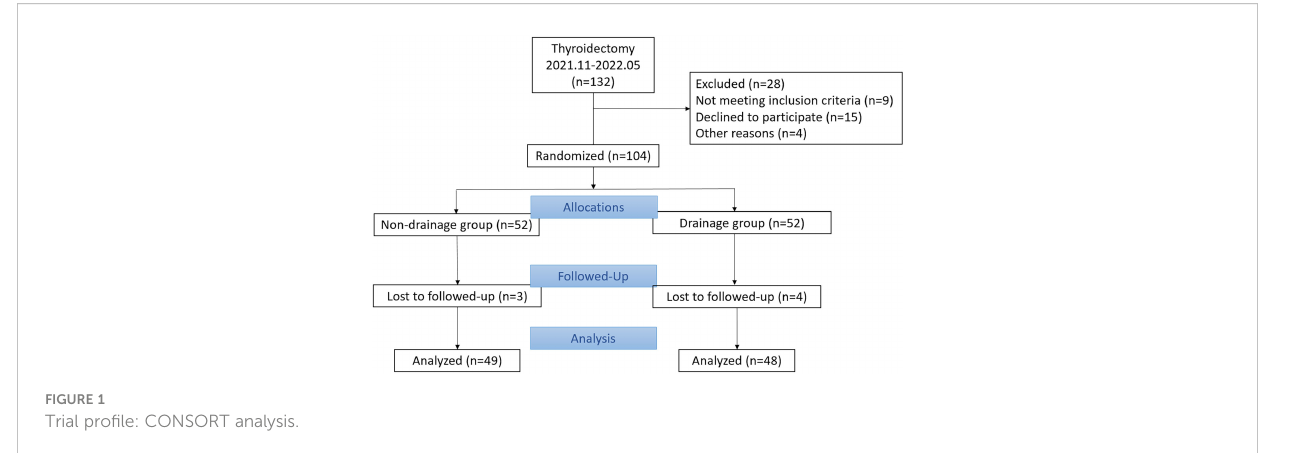
FIGURE 1 Trial pro fi le: CONSORT analysis.